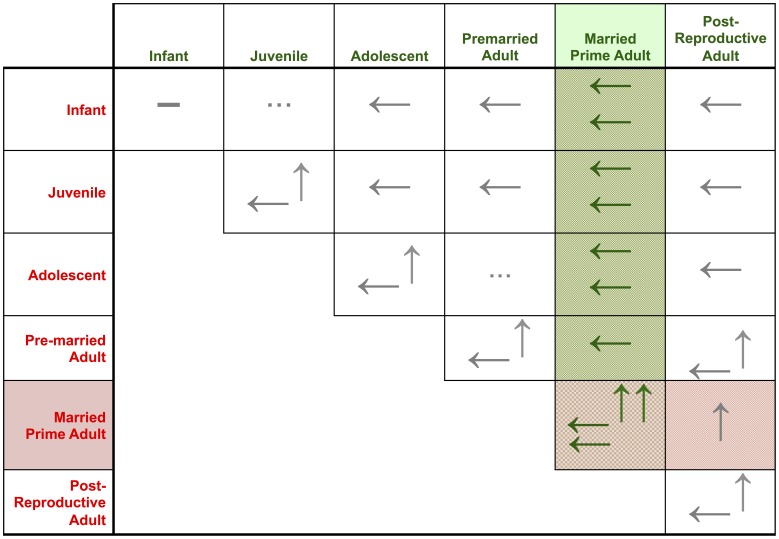
Typical preindustrial flow of transfers in human groups among all life history stages, emphasizing the importance of giving and receiving for prime adults engaged in family formation, investment in fertility, and offspring and descendant care.Transferred resources include consumable calories, material capital, social capital, technological know-how and environmental knowledge, and cultural competence. The preponderance of exchange within life history stages occurs among married adults and involves a combination of material and social capital, including reputation. In turn, married adults account for the bulk of transfers to other life stages. Modified after ref. [37].